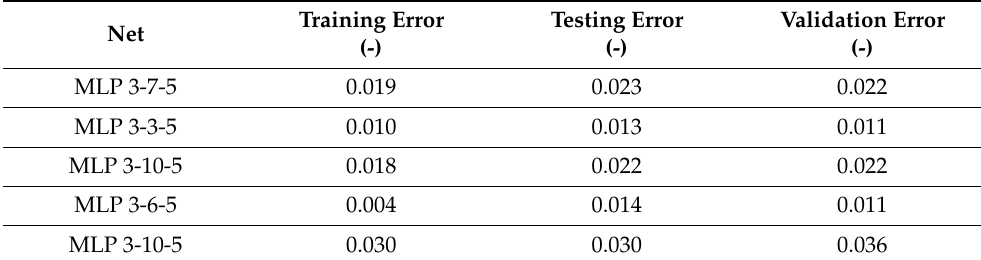
Table 4. Error propagation in the best neural networks.